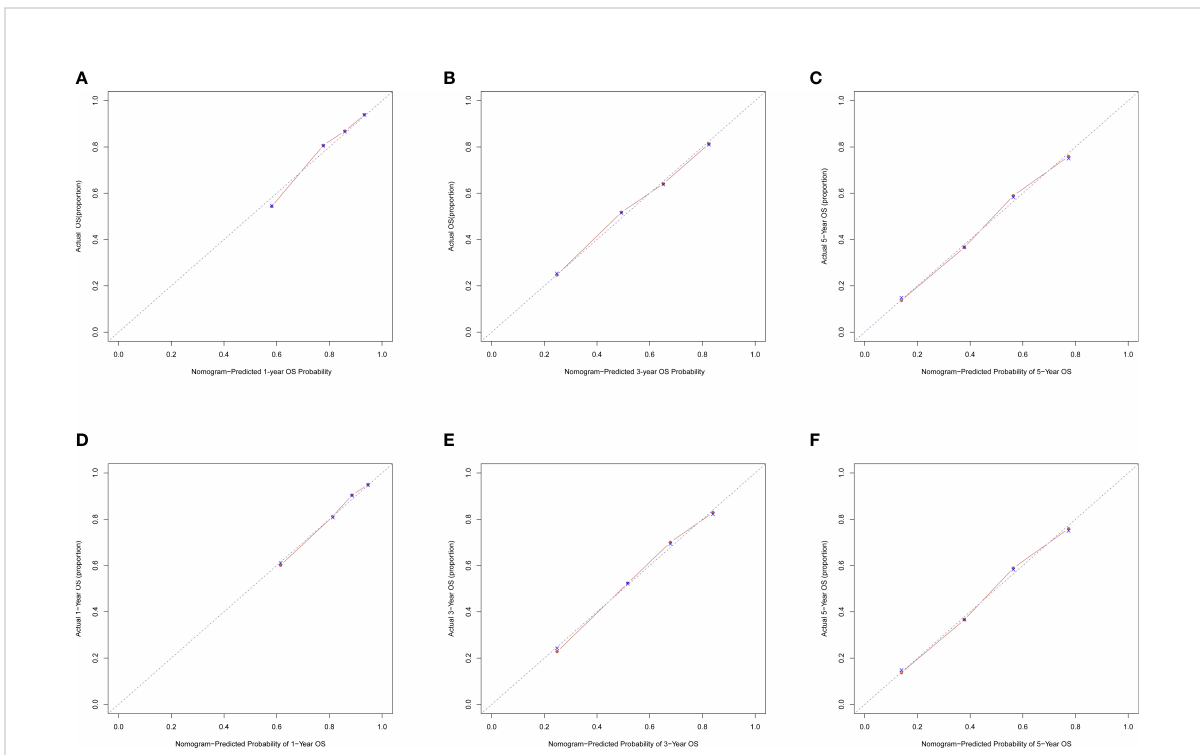
FIGURE 3 Calibration curves of nomogram. (A) For 1-year OS in training cohort; (B) For 3-year OS in training cohort; (C) For 5-year OS in training cohort; (D) For 1-year OS in validation cohort; (E) for 3-year OS in validation cohort; (F) for 5-year OS in validation